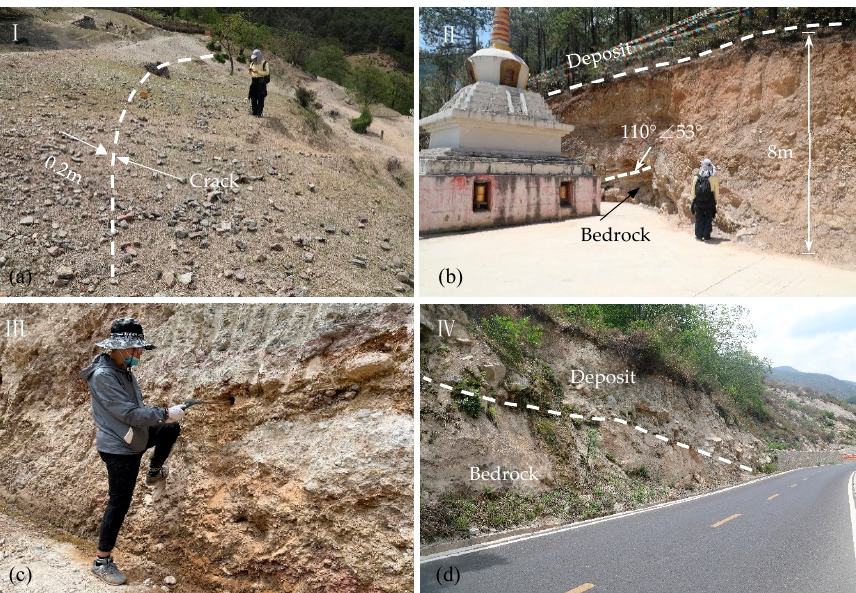
Figure 10. Field photos of areas I to IV. ( a ) The tensile crack at the trailing edge of the small landslide in area I; ( b ) the artificial excavation section in area II; ( c ) the artificial excavation section in area III; ( d ) bedrock outcrop at the bottom of the KZG